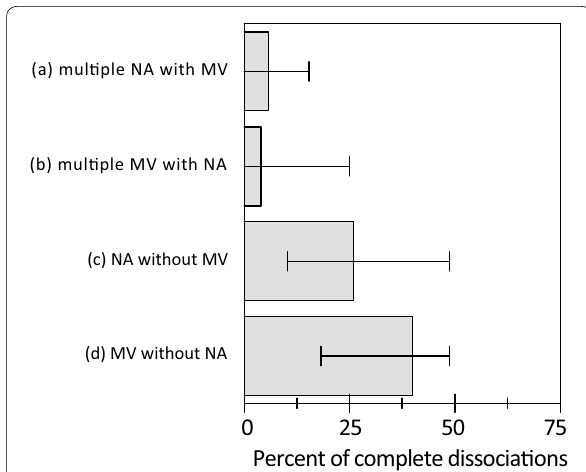
Fig. 2 Rates of multiple NA with MV (a), multiple MV with NA (b), NA without MV (c) and MV without NA (d) as classified by the automated analysis. Columns are median, and bars are interquartile range